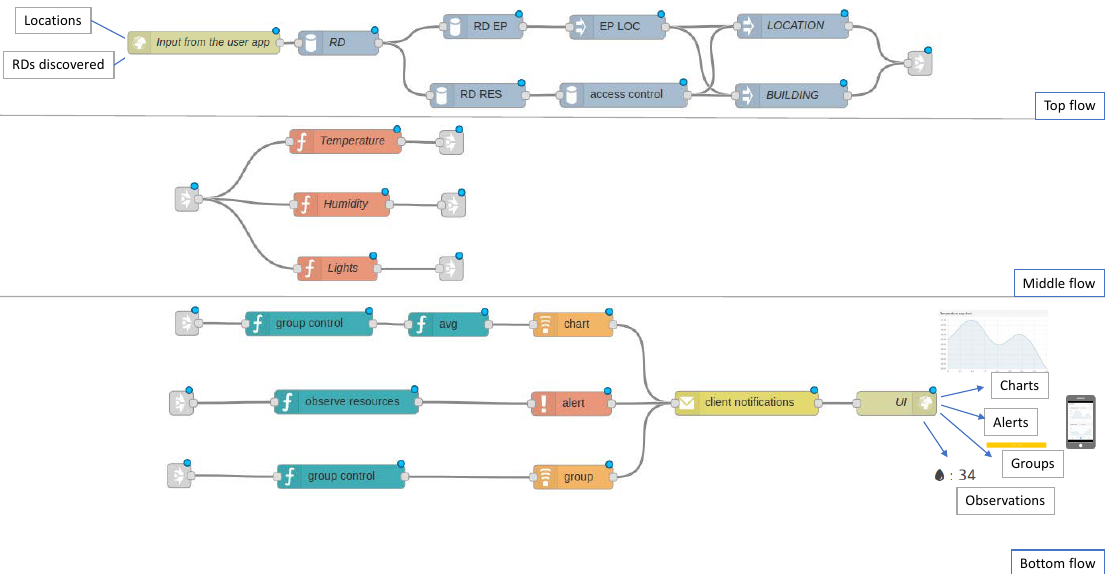
Figure 6. PoCo configuration with building and location flows, access control, and different